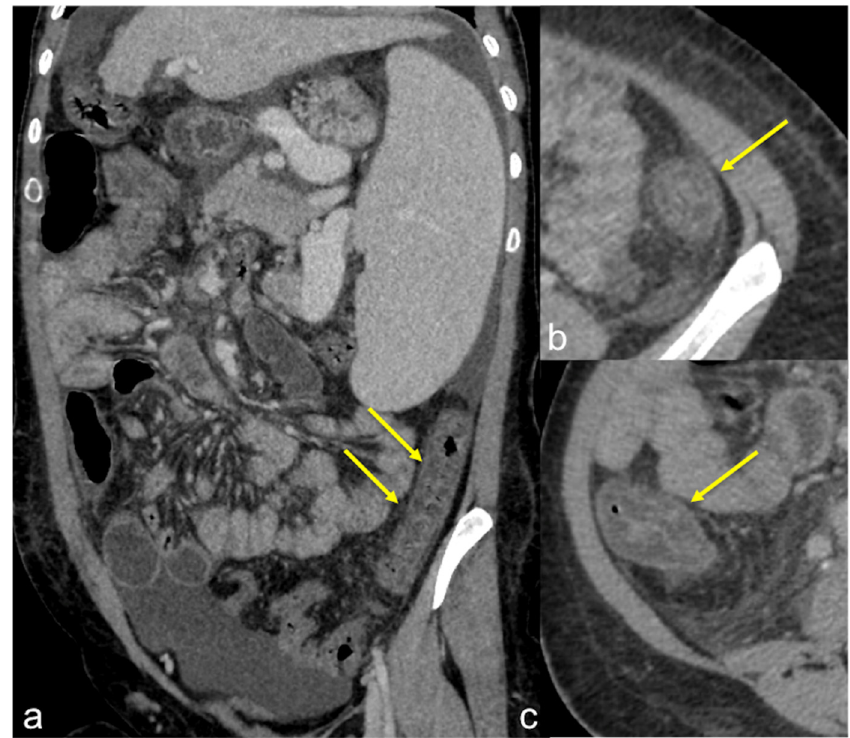
Figure 41. Ischaemic colitis in a cirrhotic patient. Enhanced CTA scan in portal venous phase in coronal-oblique ( a ) and axial ( b , c ) views. Note the typical colonic involvement ( a – c arrows) with stratified wall thickening with submucosal oedema, mucosal hyperaemia and adja- cent mesenteric stranding.